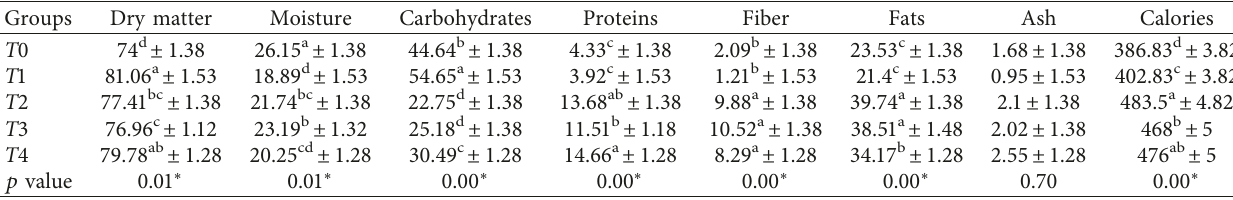
Table 4: Proximate analysis of various gluten-free cupcakes and